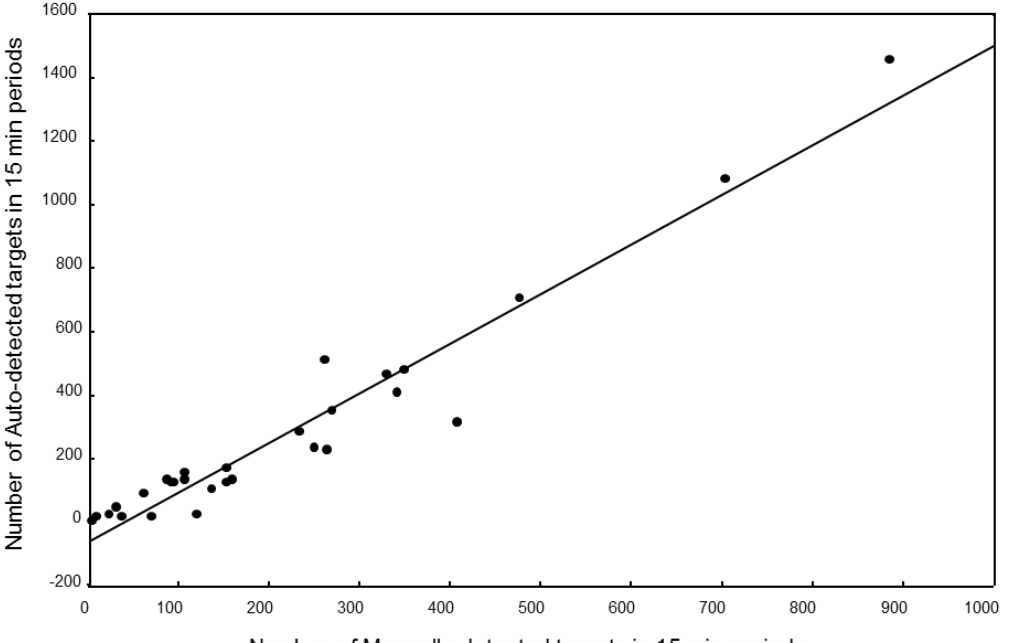
Fig. A1.1 . Relationship between the estimated number of targets detected from 29 15-min sample periods of radar data processed in with the Autodetection method compared to the number of nocturnal migrants identified using the Manual-detection method of the same data. Estimated numbers were established through autotracking functions in radR using the using the highest-performing combination of values for blip filtering and tracking tested ( R 2 = 0.94, intercept = -61.38, slope = 1.56). All data were collected at the Dokie I Wind Energy Project from 2008 to